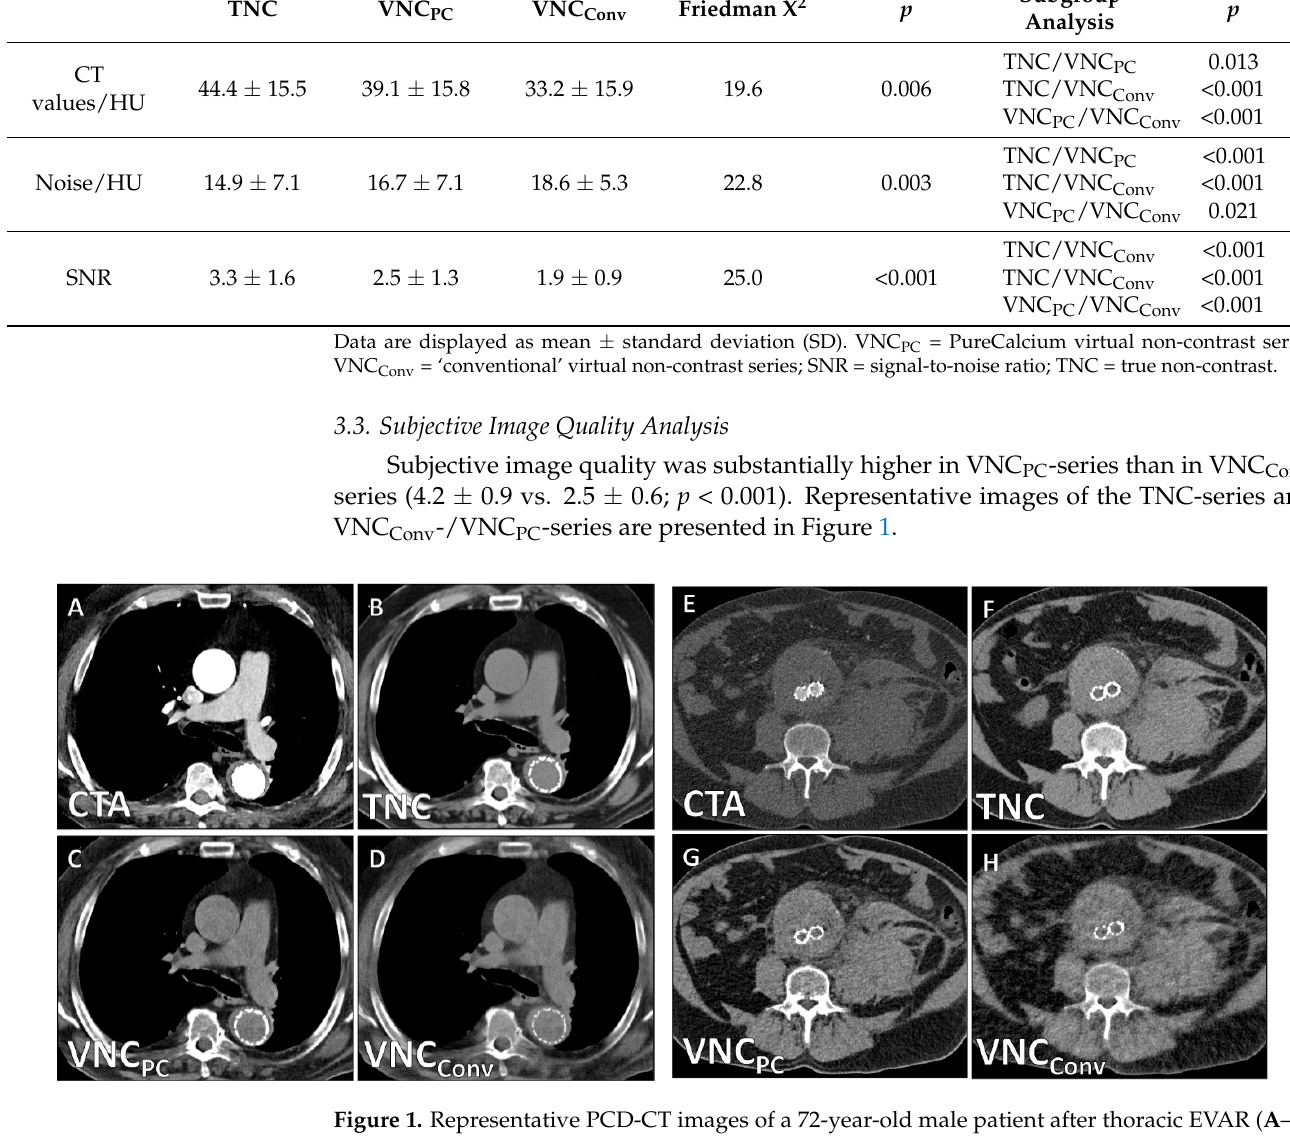
Figure 2. Erroneous removal of stent struts in VNC Conv -reconstructions demonstrated in corre- sponding axial images in a patient after thoracic EVAR. White arrows demonstrate stent struts (reference: TNC-series A , D ) that despite lower density are well visualized in VNC PC -reconstruc- tions ( B , E ) but are absent in VNC Conv -reconstructions ( C , F ).